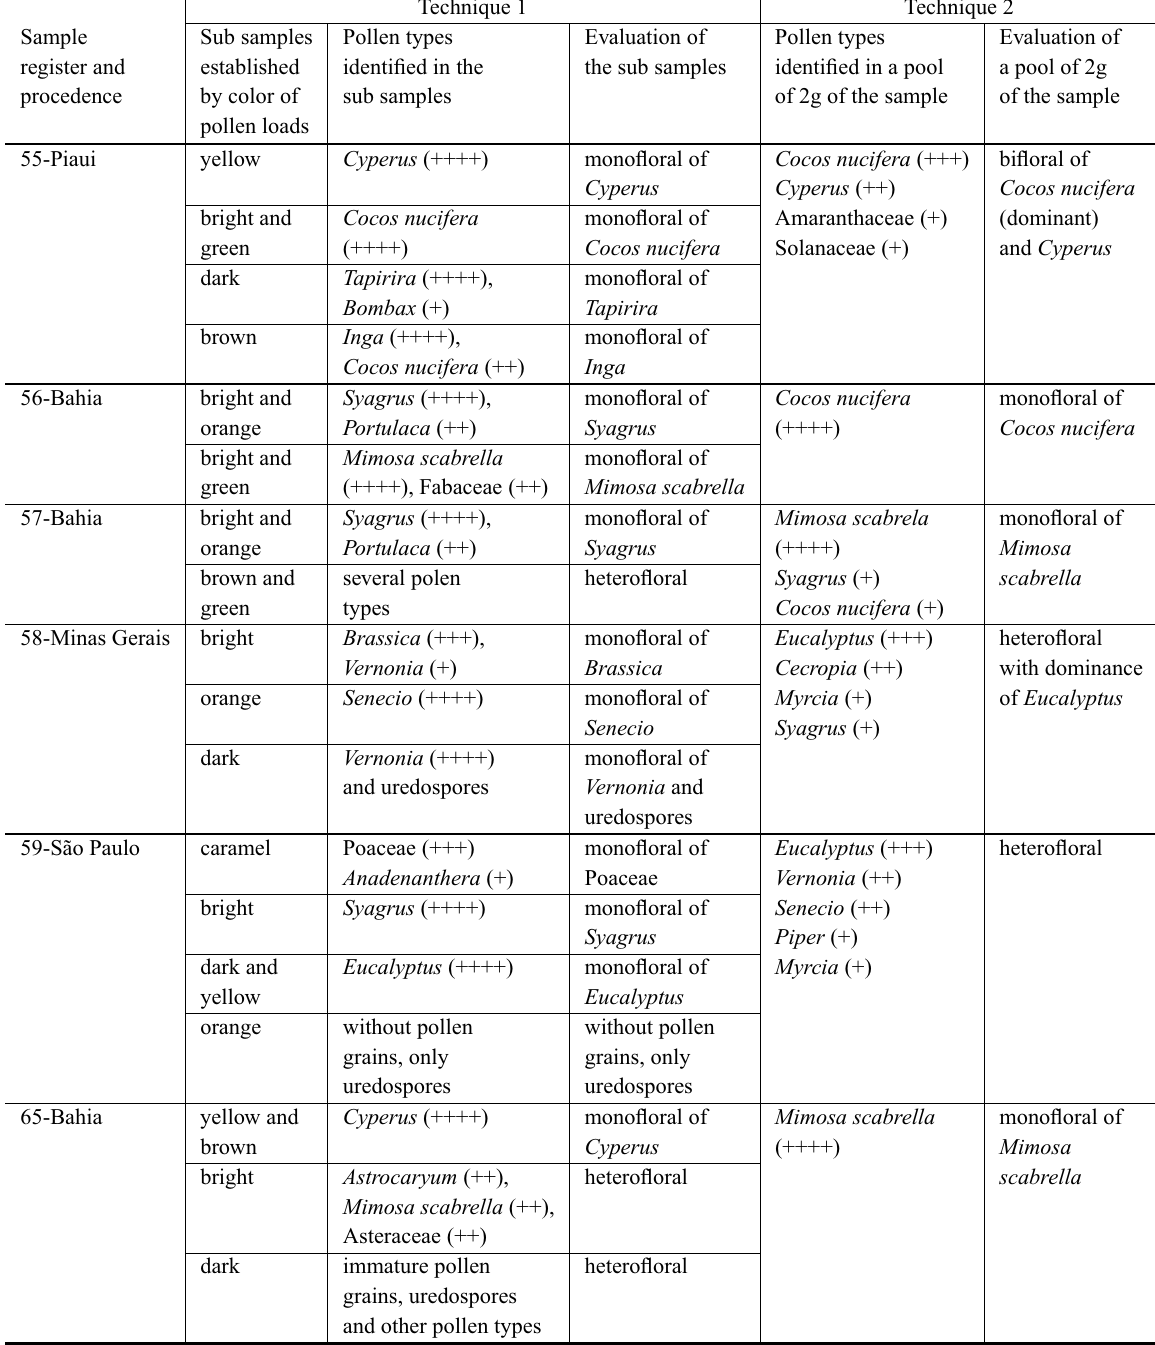
Comparison of 25 pollen load samples (2g of each batch) from Apis mellifera evaluated by its color (sub samples in columns two, three and four) and evaluated by a pool of 2g of each batch (columns five and six). Each sub sample comprised 25 units of pollen loads. Only the pollen types with frequency > 3% were considered: very frequent (++++, circa > 85%), frequent (+++, circa 45 to 85%), few frequent (++, circa 15 to 45%), rare (+, circa 3 to